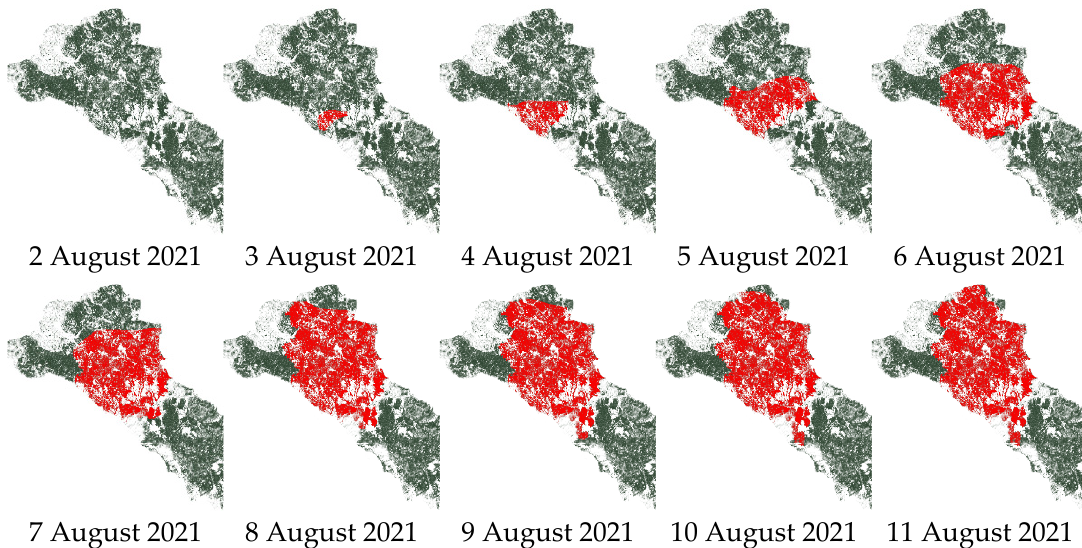
Figure 13. The evolution of fire, related to forests’ clustering, calibrated by the reports of 112 Emergency Communications Service [80].